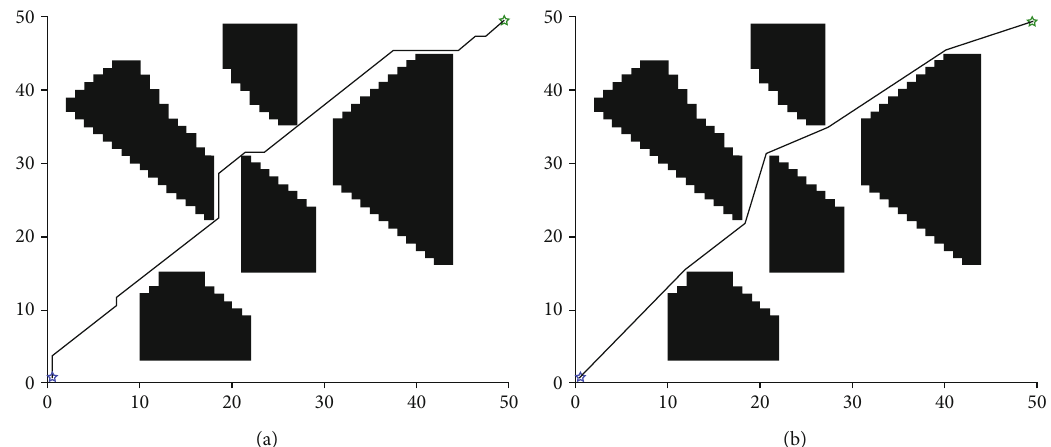
Figure 5: Comparison of the standard A ∗ and the improved A ∗ path planning results. (a) Standard A ∗ algorithm. (b) Improved A ∗